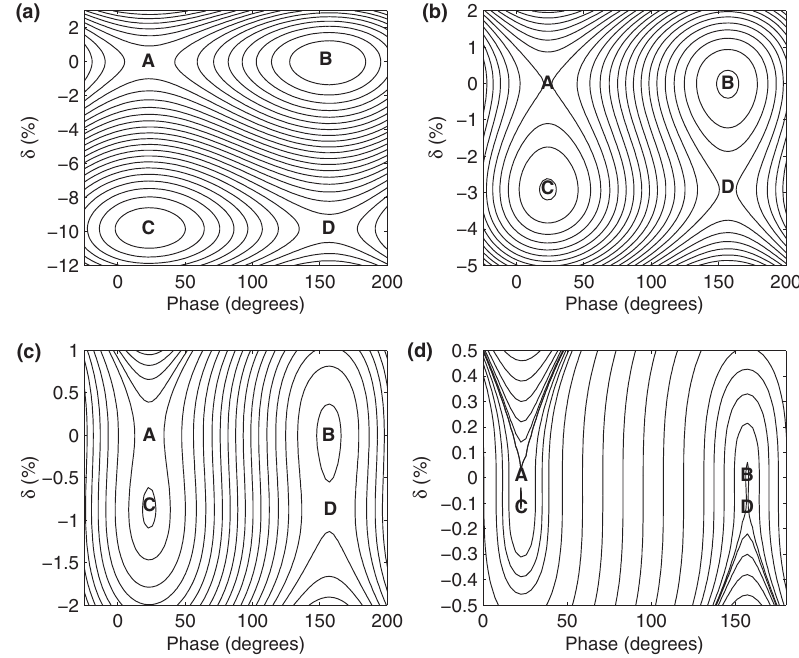
FIG. 4. Effect of the (cid:1) 2 on the longitudinal phase space for the SOLEIL using the nominal value for (cid:1) 1 ¼ 4 : 38 (cid:1) 10 (cid:2) 4 assuming 0 . The energy gap between the two rf-bucket layers decreases while the momentum acceptance (i.e. areas) (cid:6) ¼ 4 : 3 (cid:1) 10 (cid:2) 9 and (cid:1) 3 ¼ of the buckets shrinks to zero as (cid:1) 2 increases from 4 : 45 (cid:1) 10 (cid:2) 3 in (a) to 1 : 5 (cid:1) 10 (cid:2) 2 in (b), 5 (cid:1) 10 (cid:2) 2 in (c), and 5 (cid:1) 10 (cid:2) 1 in (d). No energy shift occurs in contrast to the effect of the (cid:6) parameter. The stable and unstable fixed points are respectively (A, D) and (B, C).